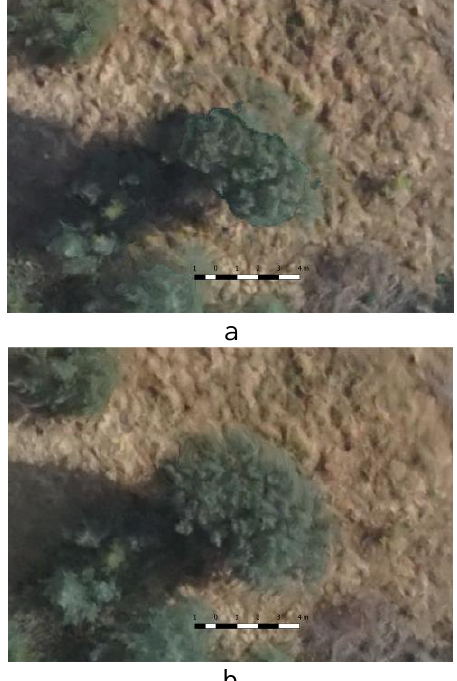
Figure 8. Representation of vegetation in the (a) fixed-wing and (b) multi-rotor imagery.